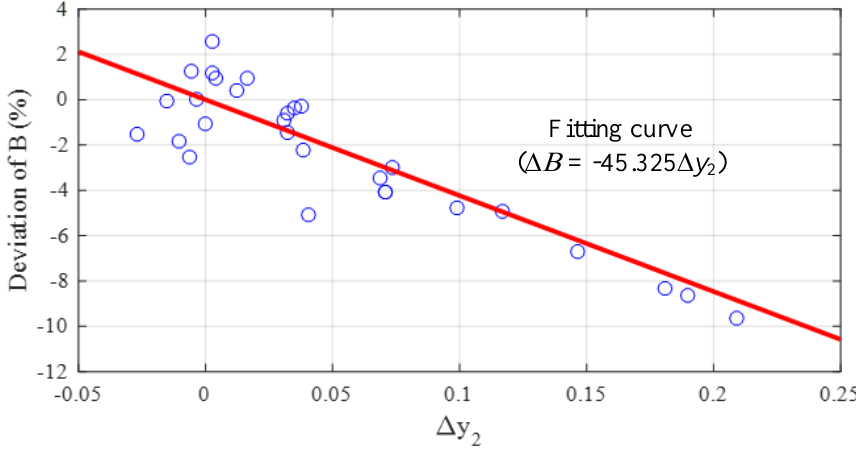
Figure 7. Deviation of B versus the undershoot factor ( Δ y 2 ).